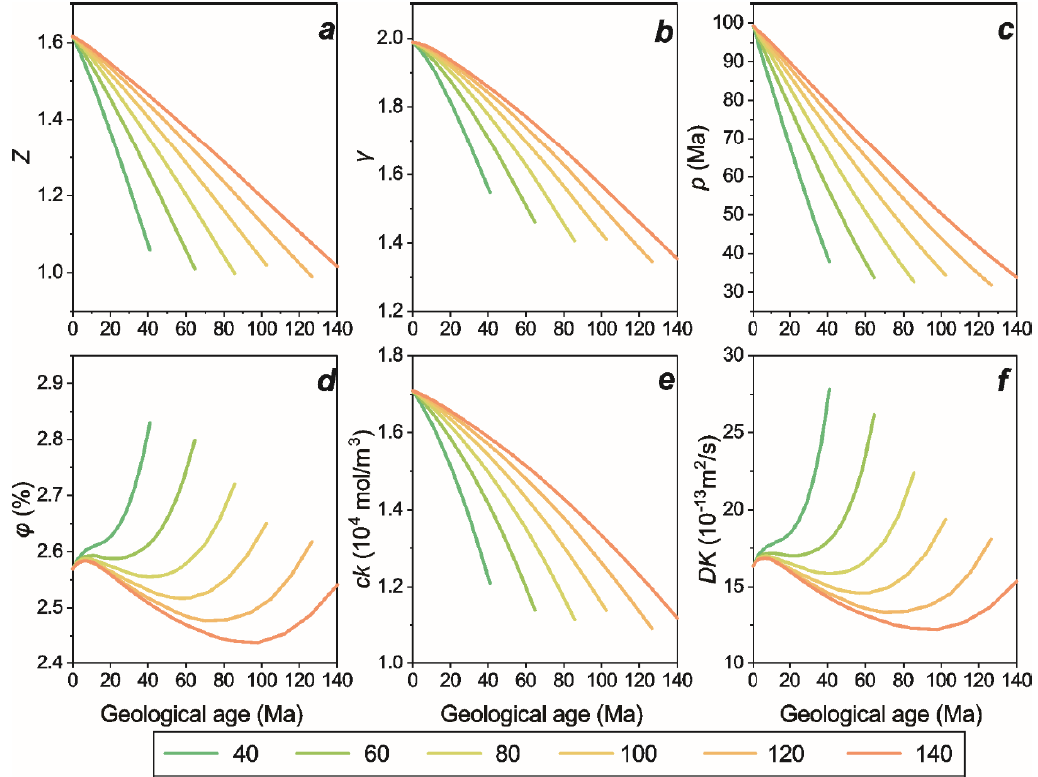
Figure 15. Evolution of compression coefficient ( a ), pressure coefficient ( b ), reservoir pressure ( c ), porosity ( d ), free gas concentration ( e ) and diffusion coefficient ( f ) under different initial lifting times ( TL ) of the CN well after uplift.